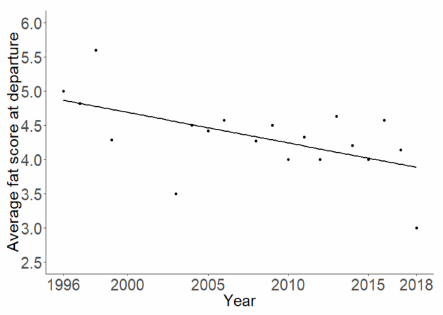
Figure 5. Average fat score of the Pied Flycatchers at departure over the